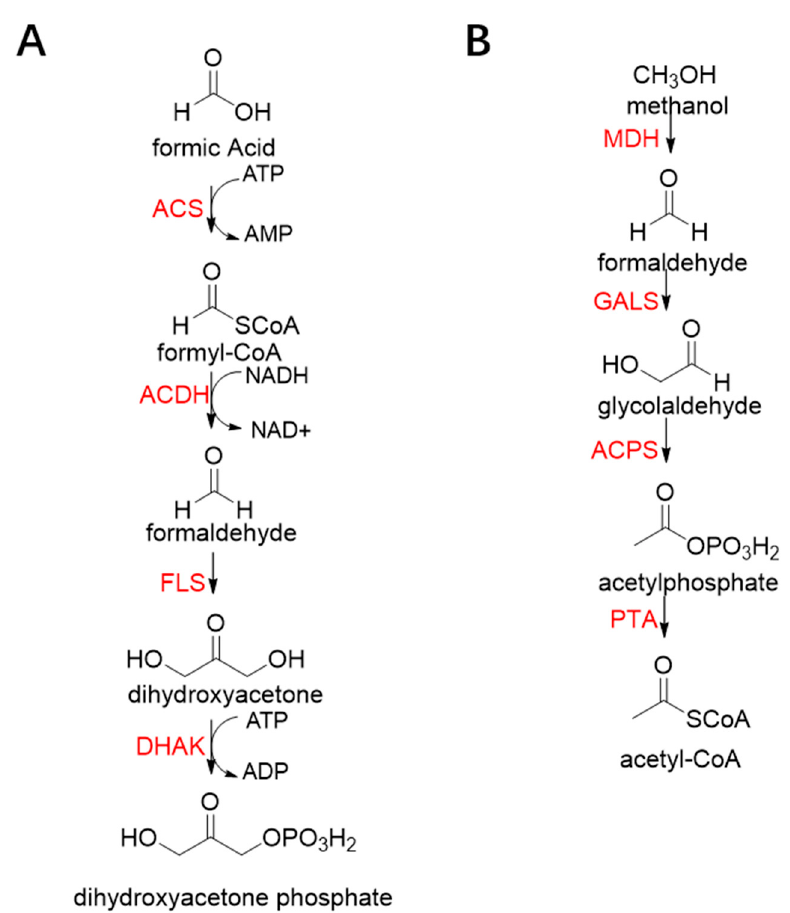
Figure 12. The formolase (FLS) pathway [22] and synthetic acetyl-CoA (SACA) pathway [23]. ( A ) The formolase (FLS) pathway. ACS, acetyl-CoA synthase; ACDH, acetaldehyde dehydrogenase; FLS, formolase; DHAK, dihydroxyacetone kinase. ( B ) The synthetic acetyl-CoA (SACA) pathway. GALS, glycolaldehyde synthase; ACPS, acetyl-phosphate synthase; PTA, phosphate acetyltransferase. Benzoylformate decarboxylase (BFD, EC 4.1.1.7) is also a ThDP-dependent